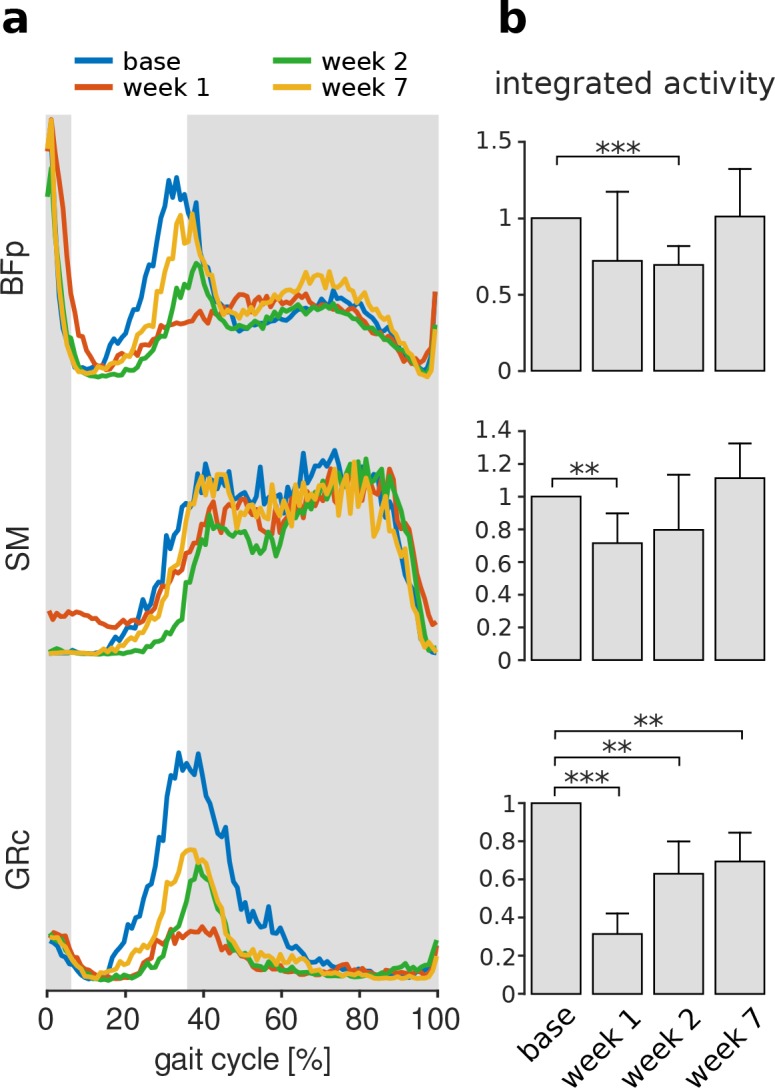
Activation of muscles with hip extension actions over the adaptation period.Conventions are the same as in Figure 3. Panel (a) depicts the averaged EMG envelopes (Ns = 104, 102, 96, 88 strides for base, week 1, week 2 and week 7 respectively) from the same animal as shown in Figure 3. Activation of BFp and SM decreased initially after VL paralysis but recovered to activation levels similar to baseline after 7 weeks. Activation of GRc remained lower than baseline even at 7 weeks after VL paralysis. Bars in (b) show average integrated activity related to the stance phase for each muscle, expressed as a multiple of the baseline values. Bars are averages ± s.d. across animals. BFp: pweek1 = 0.595, pweek2 <0.001, pweek7 = 1; N = 5, 4, 5, 4 animals contributed to base, week 1, week 2 and week 7, with an average number of strides of Ns = 70, 70, 48, 78 respectively. SM: pweek1 = 0.007, pweek2 = 0.491, pweek7 = 0.313; N = 4, 4, 4, 3 animals, and Ns = 79, 97, 73, 103 strides. GRc: pweek1 <0.001, pweek2 = 0.001, pweek7 = 0.001; N = 3, 3, 3, 2 animals, and Ns = 75, 97, 77, 89 strides.10.7554/eLife.38215.008Figure 3—figure supplement 1—source data 1.Integrated activity of hip extensor muscles during stance phase of locomotion.